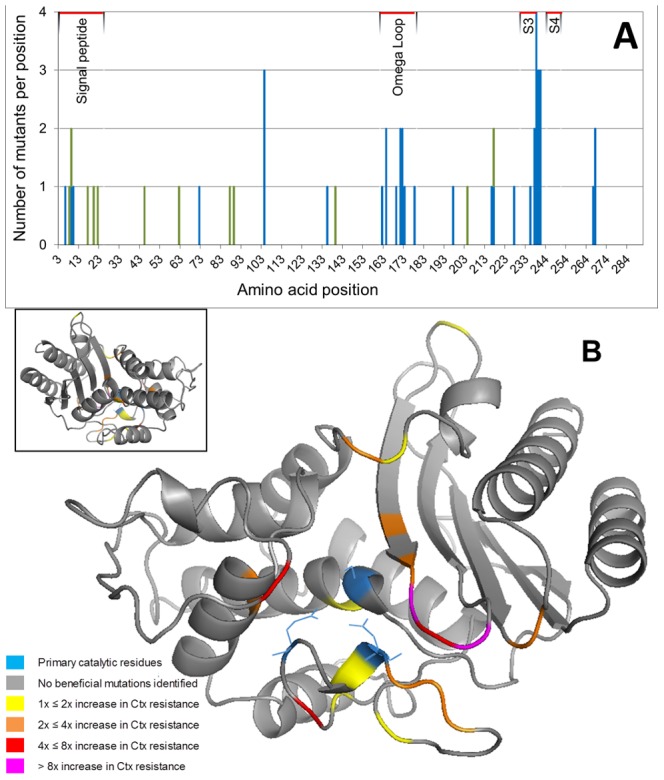
Number of observed beneficial mutations per codon and the effect sizes of the beneficial replacements.(A) Number of observed beneficial mutations per codon. Note that the numbering is based on the consensus sequence of class A β-lactamase and that codons 1, 2, 239 and 253 are not present in TEM. Green bars represent synonymous mutations and blue bars non-synonymous mutations. (B) The effect sizes of the beneficial replacements are mapped onto the crystal structure of TEM-1. Colours indicate the increase in Ctx resistance relative to TEM-1 caused by the mutation with the largest effect size at each position. The insert shows the same structure rotated horizontally by 180°.